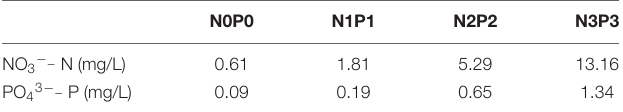
TABLE 1 | Nutrient concentrations in four different treatments. N0P0 N1P1 N2P2